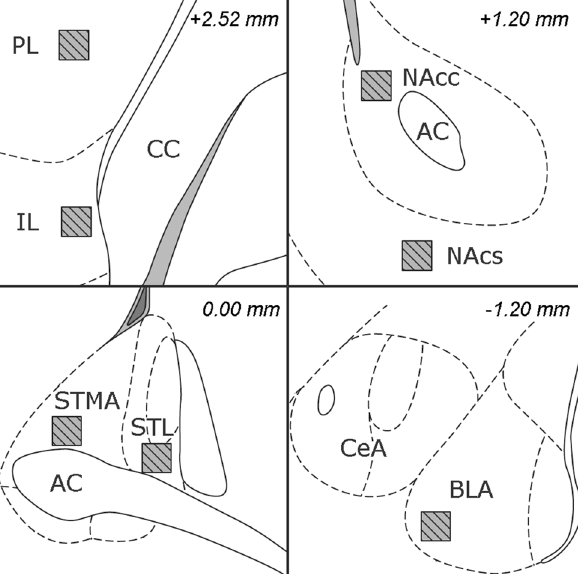
Figure 1. Regions of interest (ROIs) (200 × 200 µm) for immunohistochemistry. ROIs are indicated with hatched squares. Distance of the cross-section to bregma in the atlas is shown in the right upper corners. AC: anterior commissure, BLA: basolateral amygdala, CC: corpus callosum, CeA: central amygdala, IL: infralimbic cortex, NAcc: core of the nucleus accumbens, NAcs: shell of the nucleus accumbens, PL: prelimbic cortex, STL: lateral division of the bed nucleus of the stria terminalis, STMA: medial division of the anterior bed nucleus of the stria terminalis. Adapted from Paxinos and Watson 50